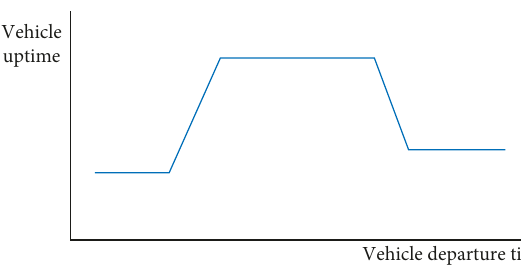
Figure 1: The vehicle uptime in time-varying